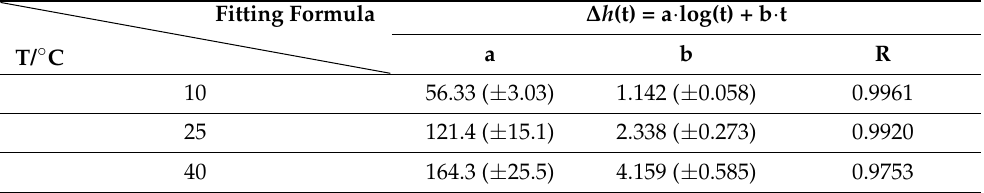
Table 1. Influencing factors during swelling and fitting (with 95% confidence bounds) at different temperatures.